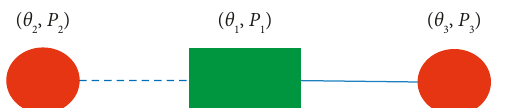
Figure 1: The chain network model. A generator (square) injects a power, and two loads (circles) consume power, each consuming a power in arbitrary units where dash line is negative coupling and solid line is positive